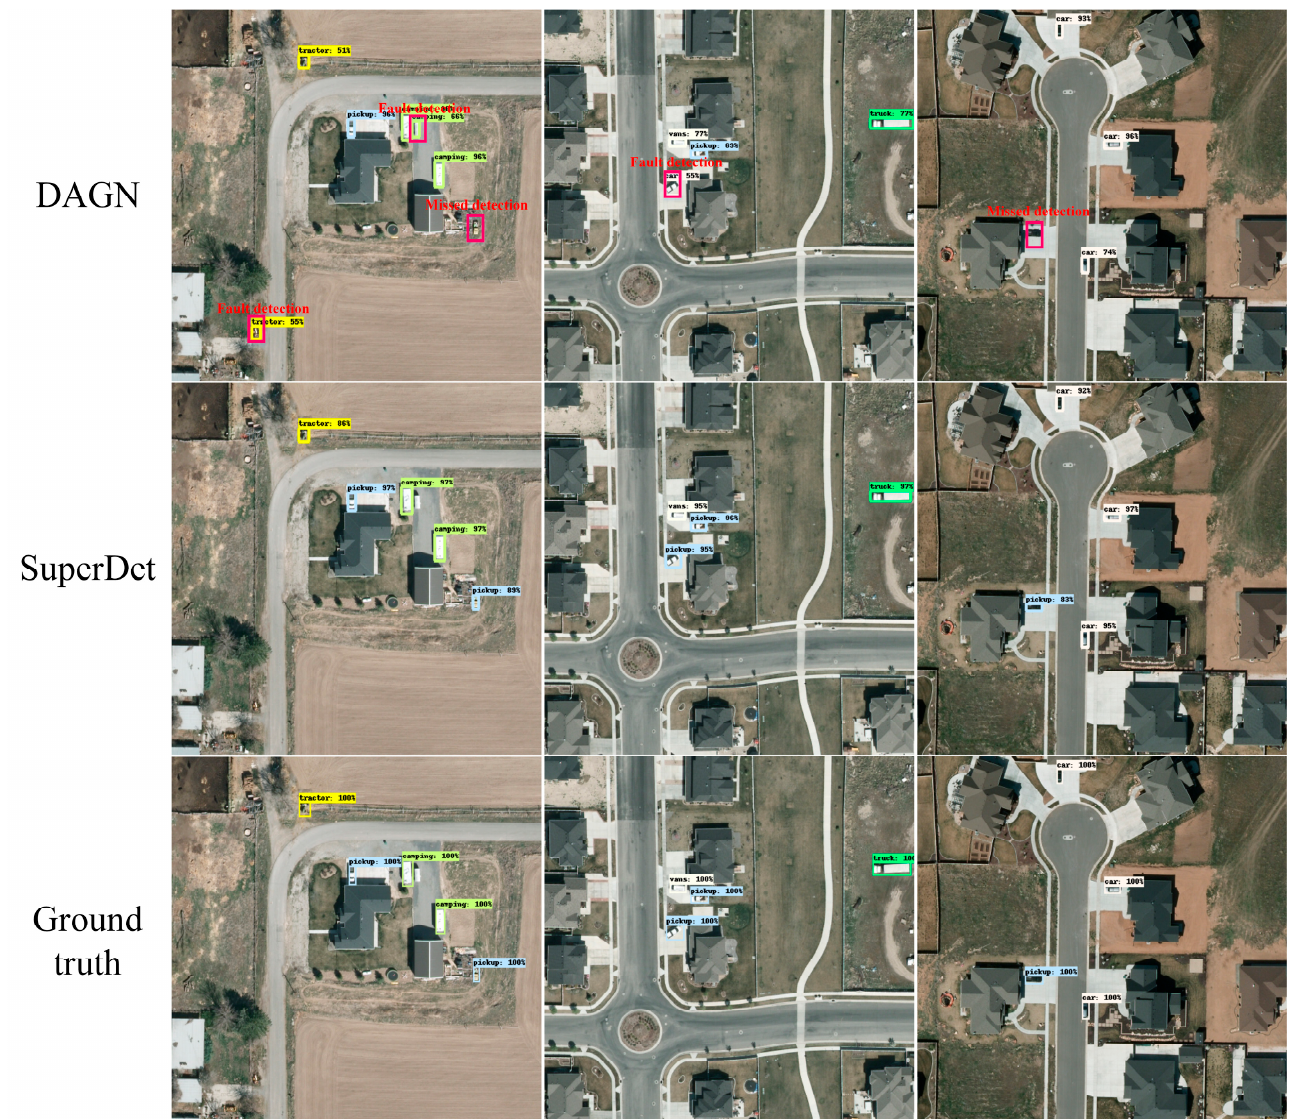
Figure 6. Visual comparative results of SuperDet on the VEDAI dataset. First row: detection results of DAGN. Second row: detection results of SuperDet. Third row: Ground truth. Table 5. Comparative results of each detector on the DOTA